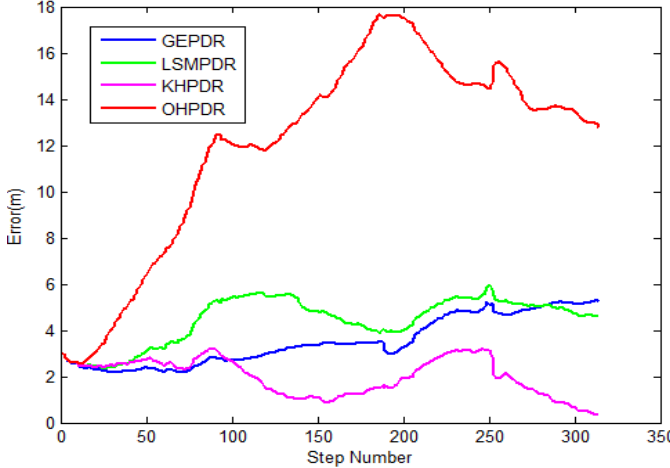
Figure 10. Positioning error analysis for different solutions associated with PDR. Table 2. Positioning error analysis for different solutions associated with PDR.